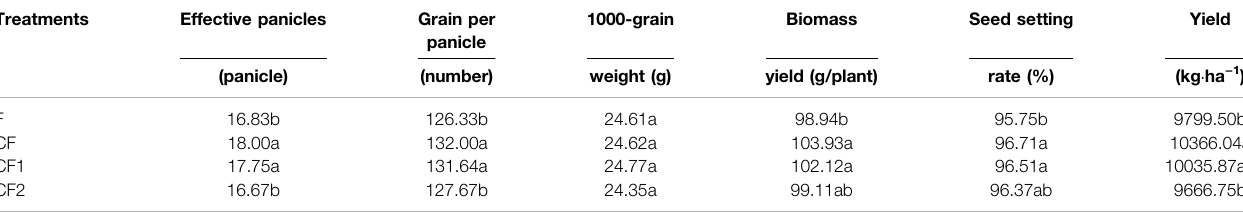
TABLE 5 | Effect of co-application of biochar and chemical fertilizers on rice yield and its components. Treatments Effective